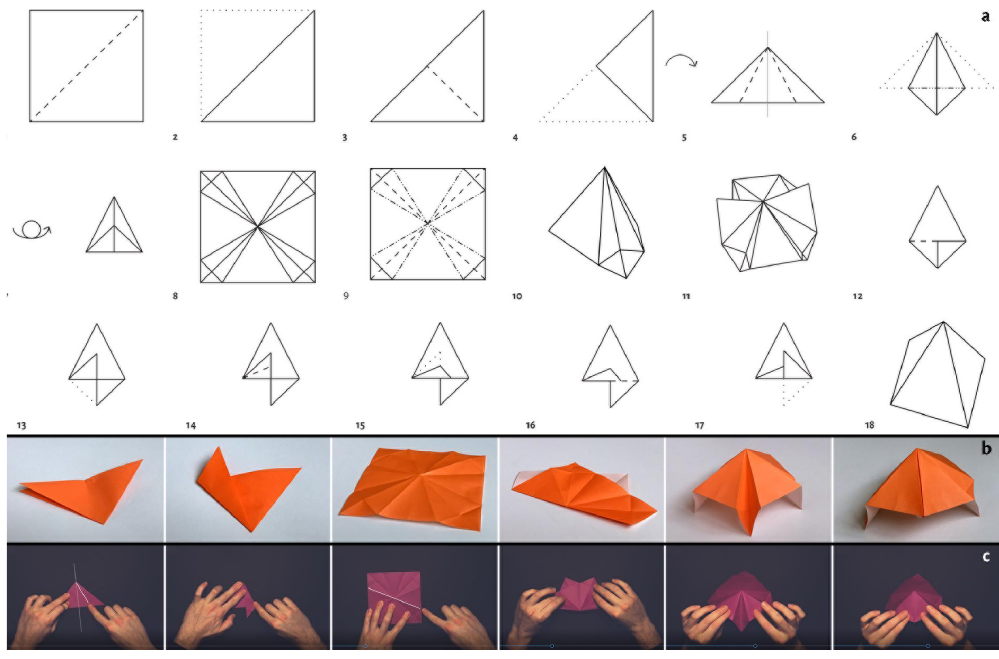
Fig. 4 Square based pyramid: folding sequence through different languages: a) folding sequence; b) photographic shots from a physical folding sequence; c) frames from a folding video